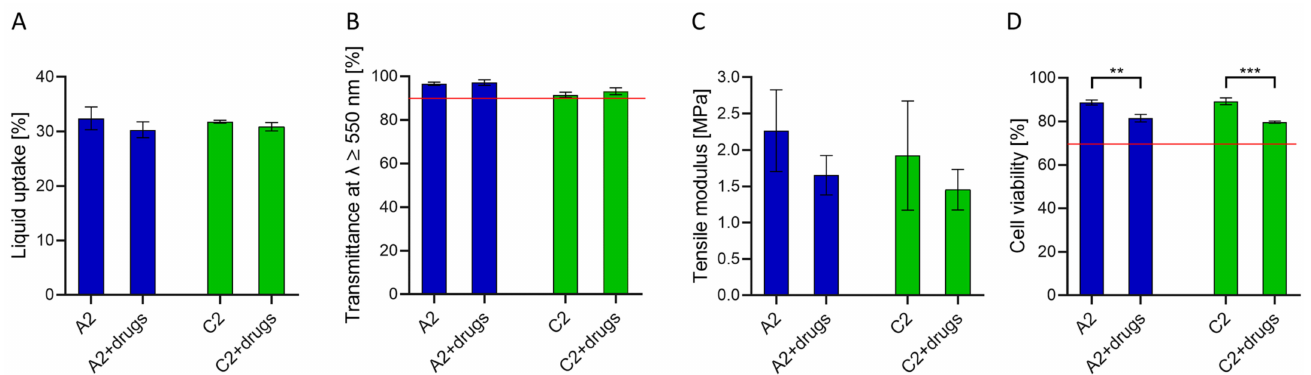
Figure 5. Characterization of the most adequate hydrogels after swelling in PBS (A2, C2) and after loading in a dual-drug solution (A2 + drugs, C2 + drugs): Liquid uptake ( A ), transmittance at λ ≥ 550 nm ( B ), tensile modulus ( C ) and cell viability ( D ). The minimum cell viability to assess non-toxicity was set at 70% (red line). t -test, ** p < 0.01, *** p <